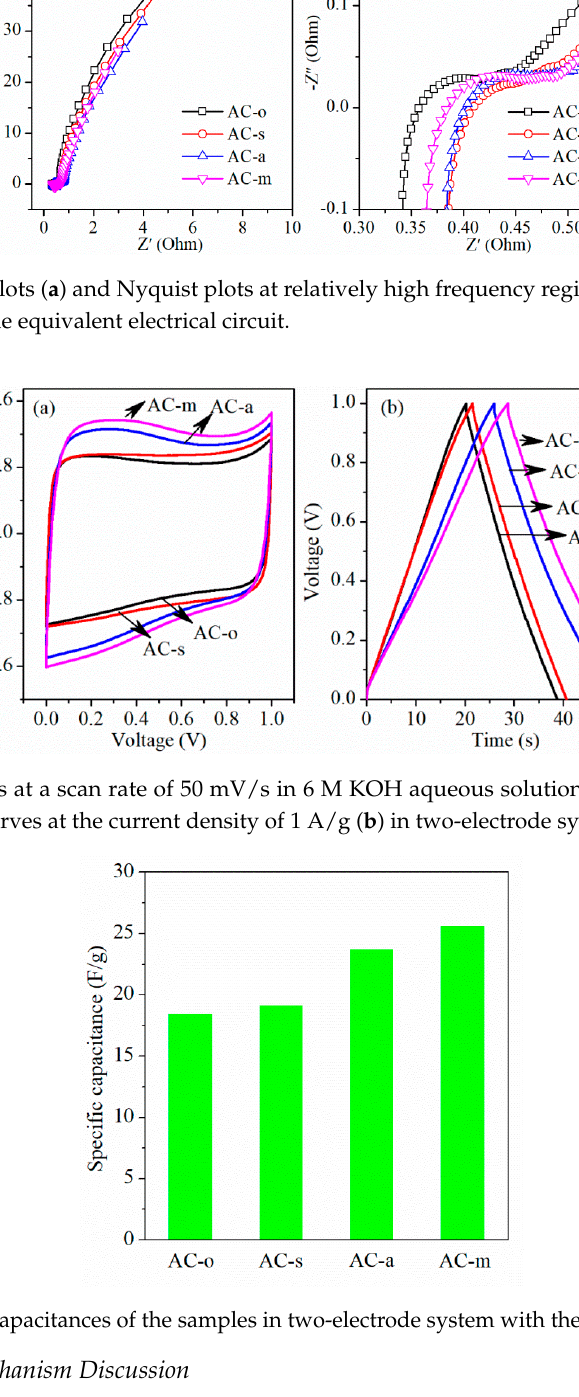
The inset showed the equivalent electrical circuit.